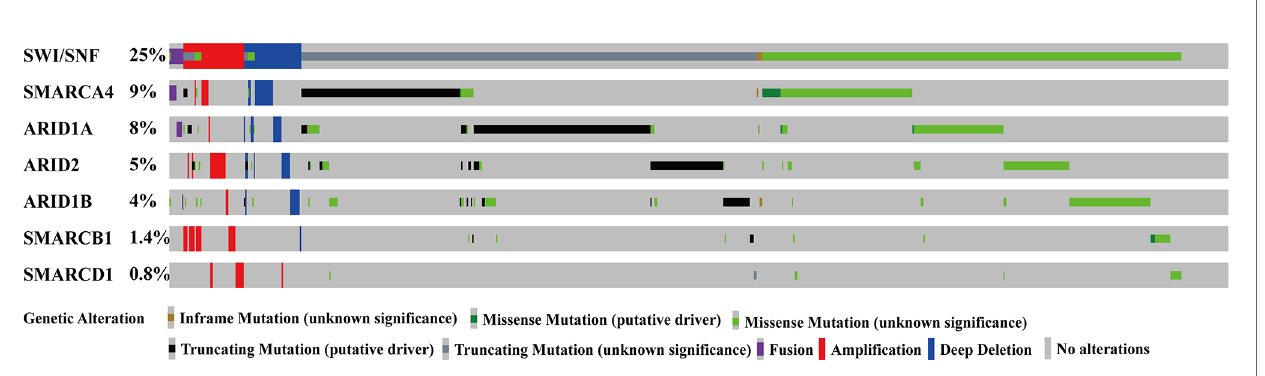
FIGURE 1 | SWI/SNF complex genes were frequently mutated in patients with NSCLC. SWI/SNF, human switch/sucrose nonfermentable; NSCLC, non-small cell lung